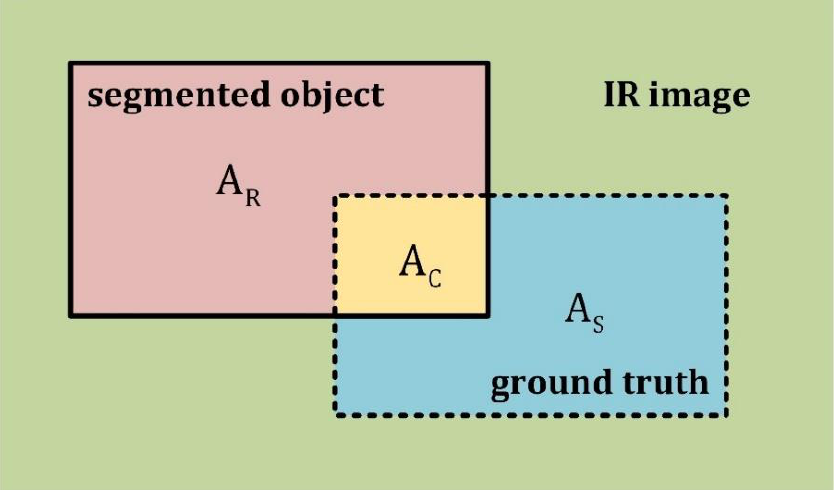
Figure 4. Schematic diagram in terms of the relationship between A R , A S and A C ,where A R , A S and A C represent the extracted region, the ground-truth object region and the correctly segmented region.